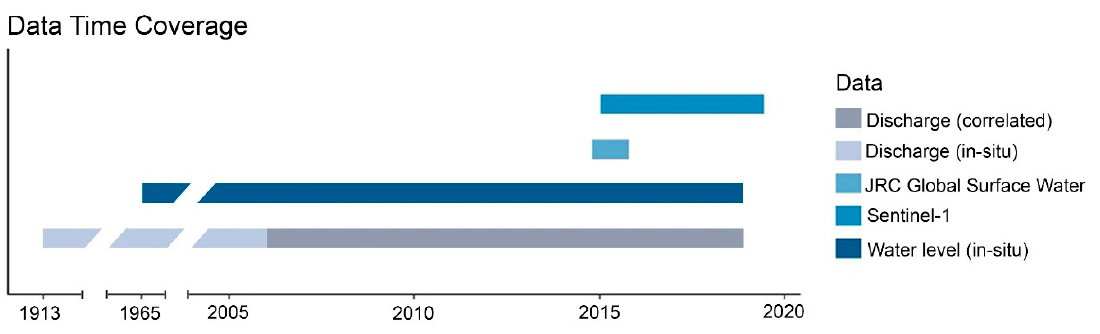
Figure 2. Temporal overview of the respective data sets.